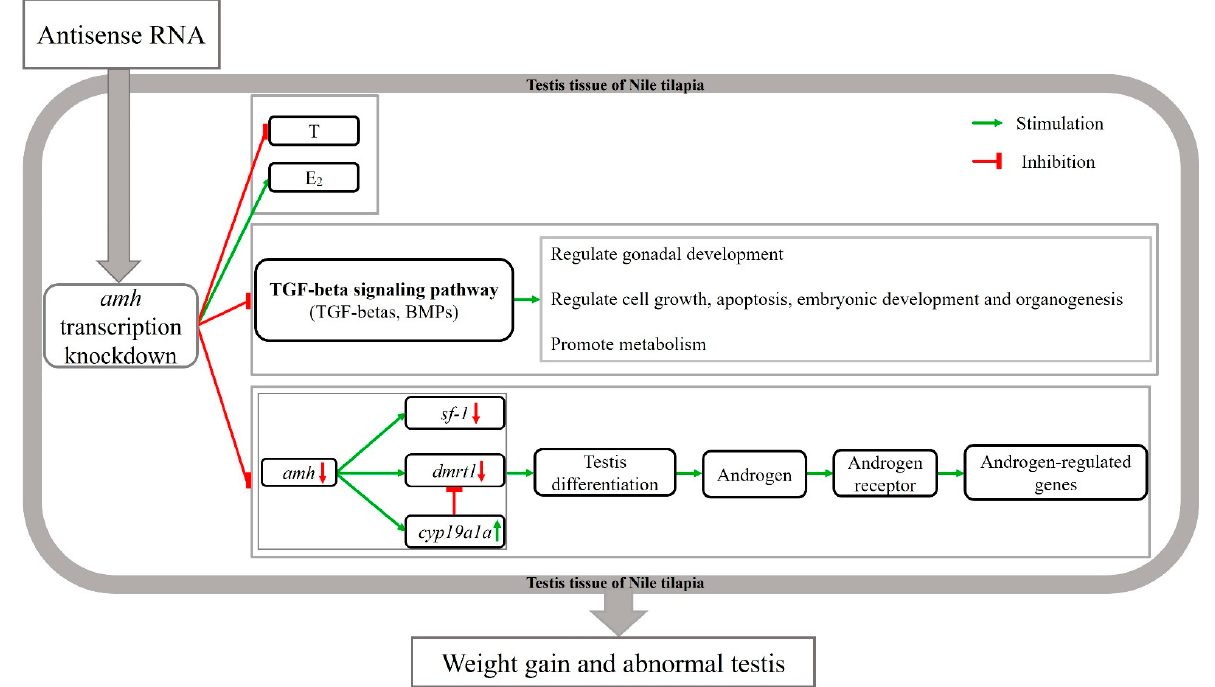
Figure 9. Schematic diagram of down-regulated amh male Nile tilapia testis development and weight gain regulation.